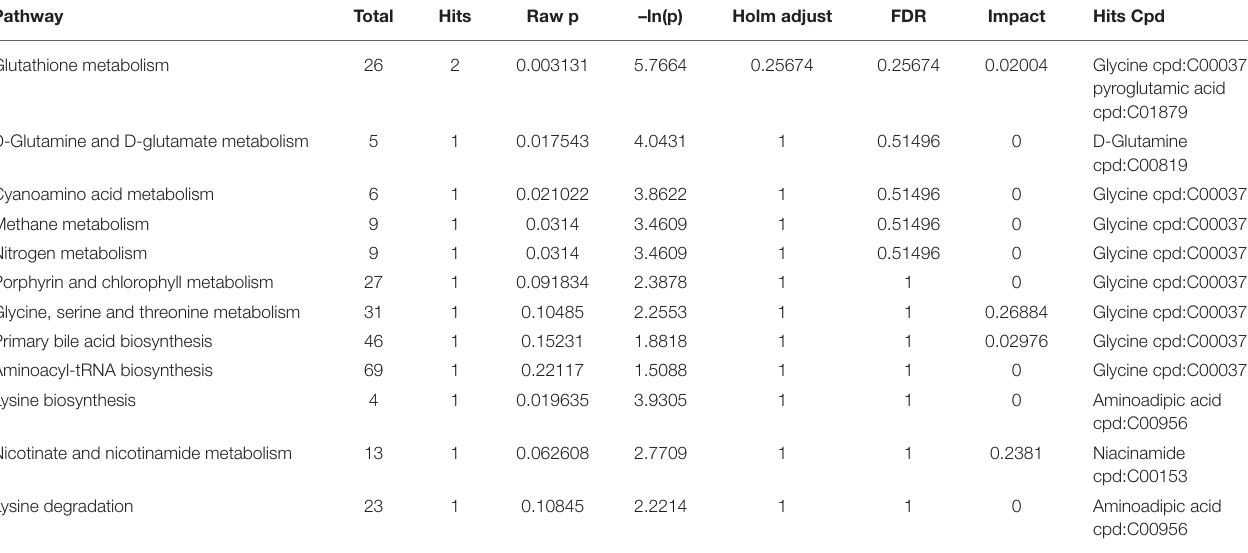
TABLE 3 | Identified differential metabolites between the HFD group and HFD + MBPs group. Pathway Total Hits Raw p –ln(p) Holm adjust FDR Hits